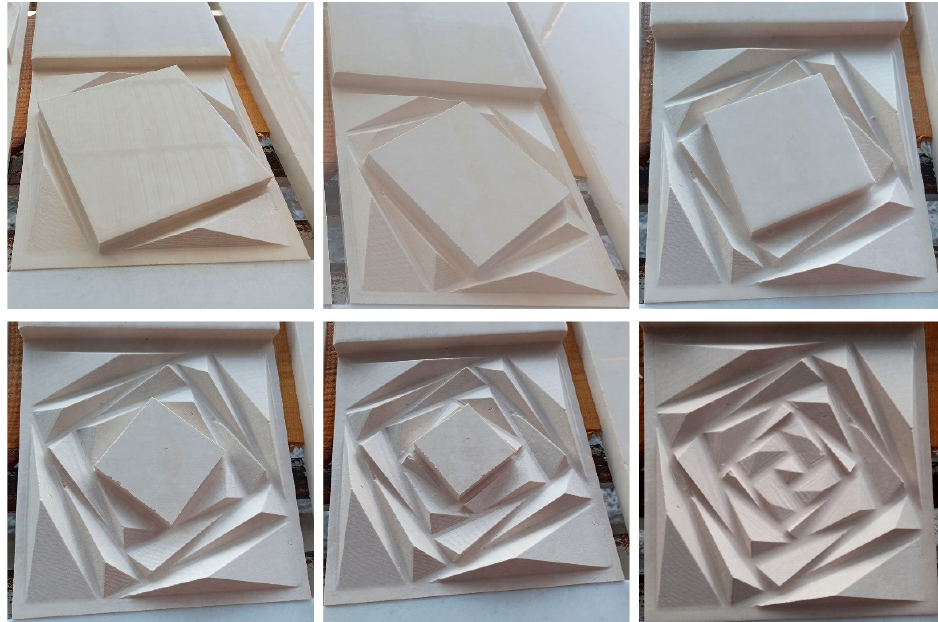
Figure 17. The results of each iteration, generated by applying different transformation rules, de- fined with corner-weight , median-weight , height , and rotation parameters at each iteration, and the re- sult of the termination rule at the last iteration.